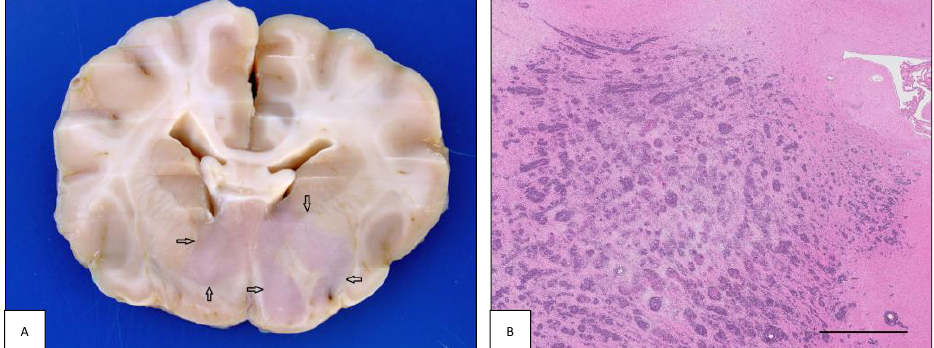
Figure 1. Intracranial lymphoma: intraparenchymal pattern. ( A ) Case #11. Dog brain section at the level of the internal capsule. A focal extensive intraparenchymal lymphoma involves the diencephalic structures (open arrows). ( B ) Case #55. Feline brain section showing perivascular arrangement of intraparenchymal lymphoma with extensive infiltration of the corona radiata and diencephalic structures. Note tissue rarefaction in the central area of the neoplasia (H&E, bar = 2.5 mm). Grossly, focal or multifocal, whitish-grey masses accompanied by swelling of the peri- tumoral parenchyma and occasionally hemorrhagic areas were observed. The histopatho- logical pattern was characterized by dense sheets of perivascularly arranged malignant cells that invaded the surrounding neuroparenchyma, creating highly cellular areas (Figure